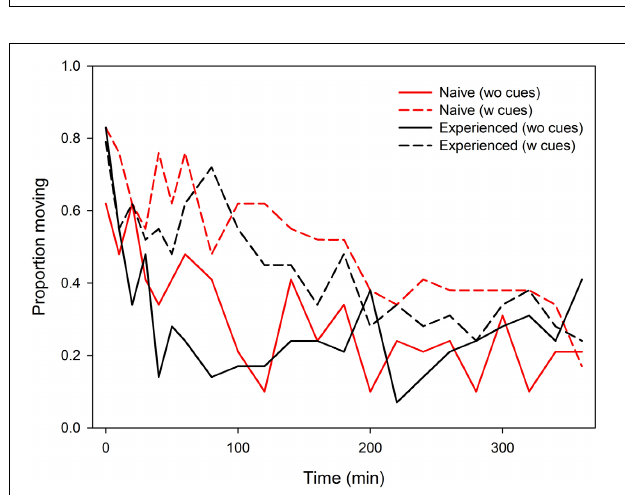
FIGURE 2 | Activity (proportion moving) of predator-naïve and -experienced spider mite females placed singly on leaf discs with (w) or without (wo) predatory mite cues over